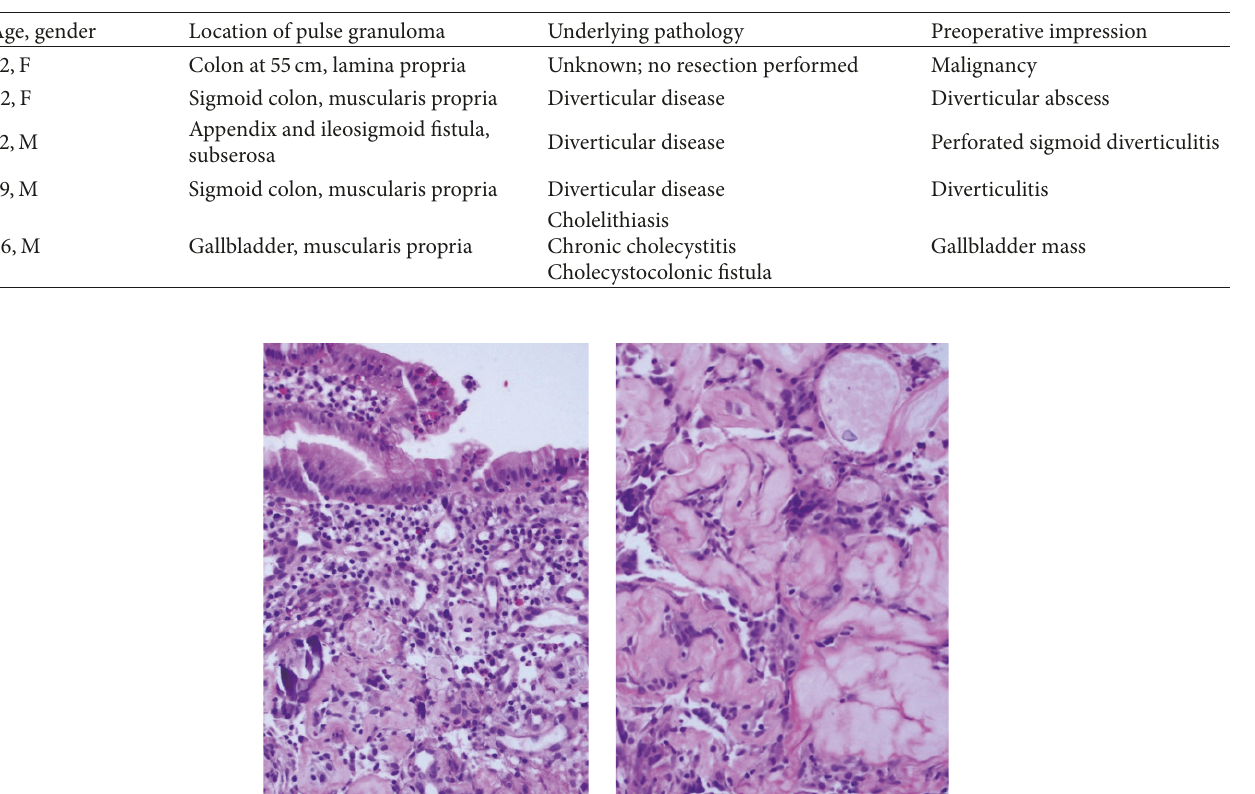
Table 1: Case summary.